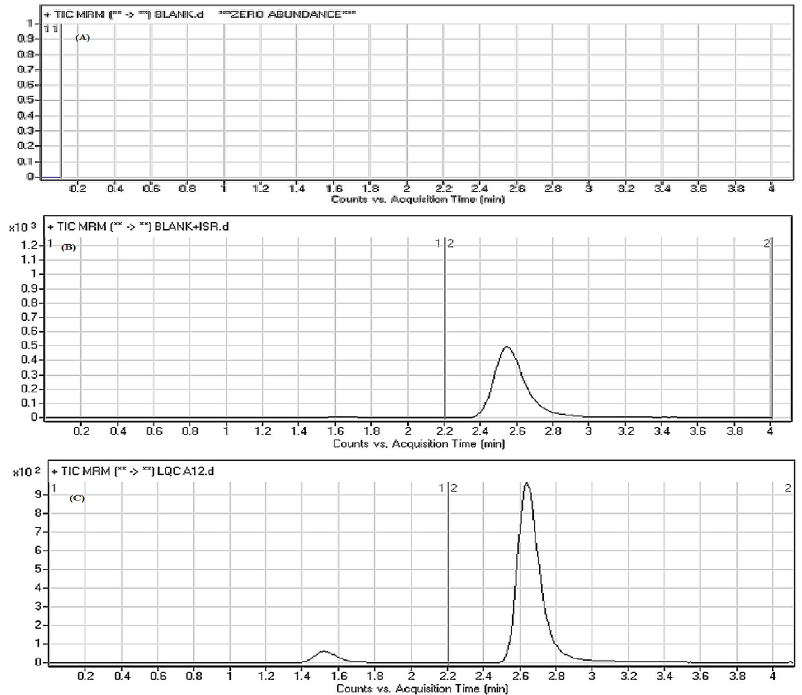
Fig 4. MRM chromatograms of blank (A), blank + IS (B), and DMB 15 ng/mL LQC (C). The blank RLM matrix revealed no matrix interference.